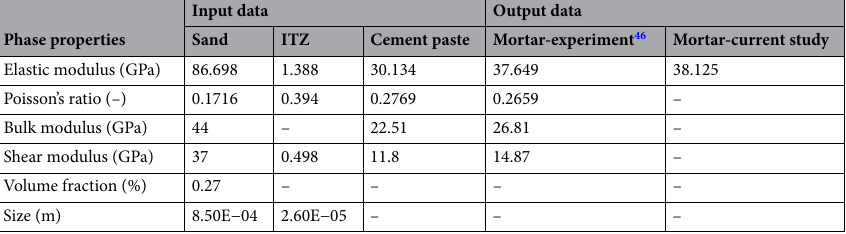
Table 11. Validation of the results at mesoscale between the current study and the experiment 46 .